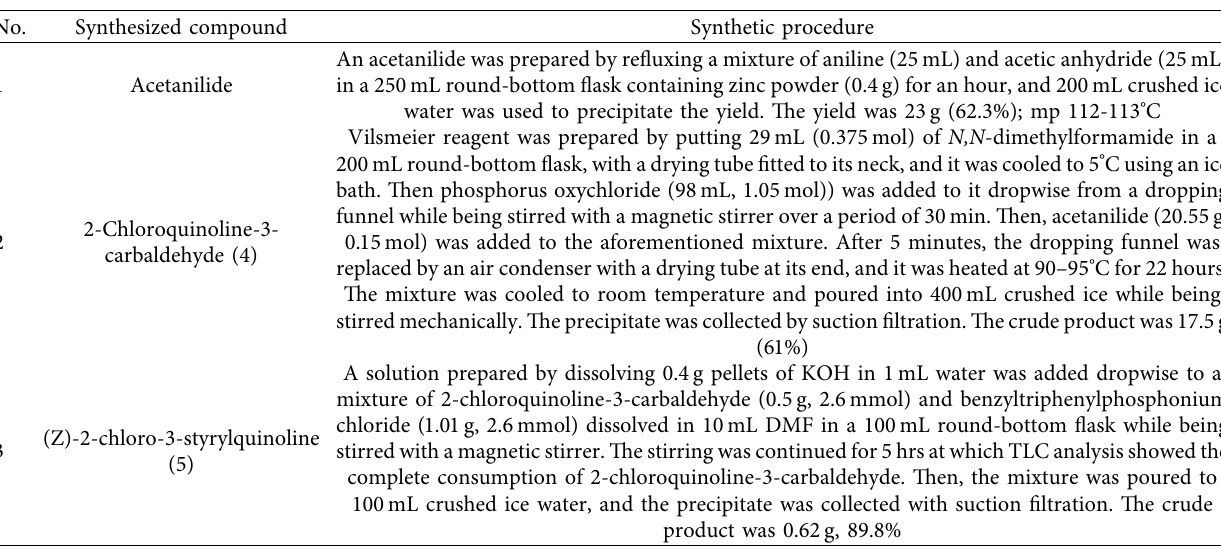
Table 1: The synthesized compound and the synthetic procedure followed.